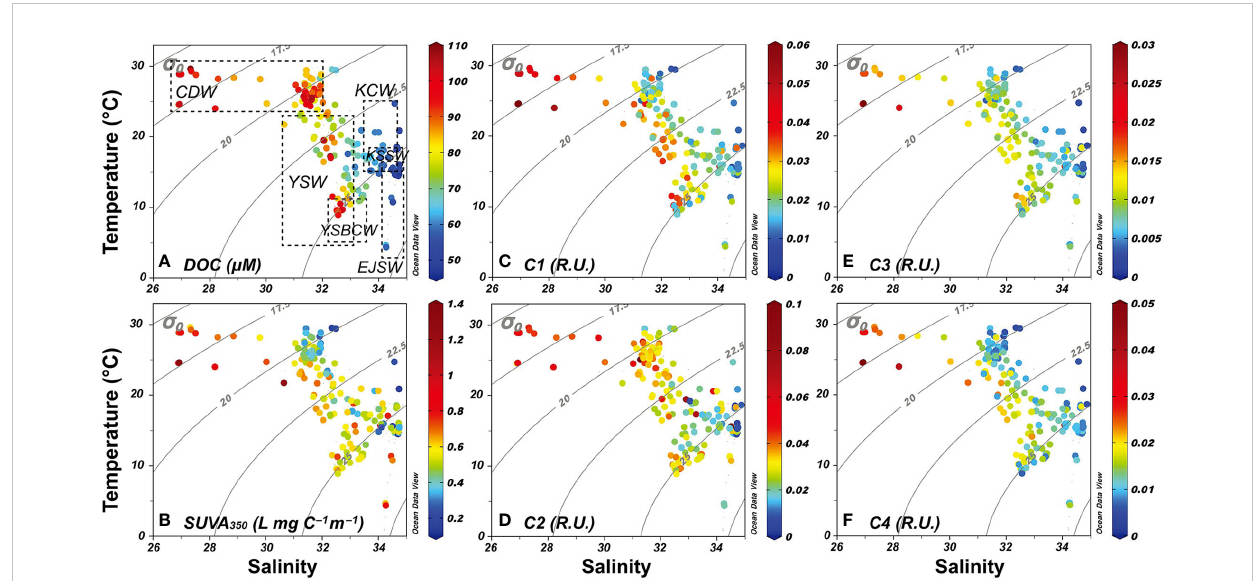
FIGURE 2 T-S diagrams of DOC concentrations (A) , SUVA 350 (B) , and FDOM components (C – F) . Each dashed box in (A) indicates different water masses in this region: the Changjiang diluted water (CDW), the Kuroshio Current water (KCW), the Kuroshio sub-surface water (KSSW), the Yellow Sea water (YSW), the Yellow Sea bottom cold water (YSBCW), and the East/Japan Sea water